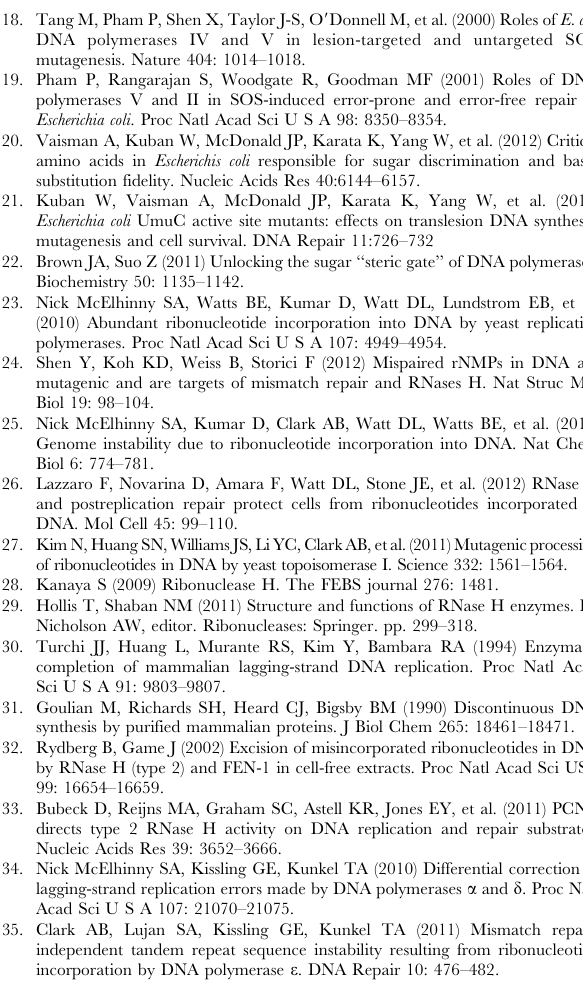
Figure S1 UV-survival of recA730 lexA (Def) D umuDC strains expressing pol V variants. Ten microliters of 10-fold serial dilutions of overnight cultures were spotted onto the surface of rectangular LB agar plates and exposed to 40 J/m 2 (panels A and C) and 10 J/m 2 (panel B) 254 nM UV-light. Both unirradiated ( 2 ) and UV-irradiated ( + ) plates were incubated overnight at 37 u C. In each panel, UV survival is shown for the recA730 lexA (Def) D umuDC strains either harboring pGB2 vector, or expressing pol V variants. Figure S2 UV-survival of recA730 lexA (Def) D umuDC polB + / D polB strains expressing pol V variants. Panel A and C, rnhB + ; Panel B and D, D rnhB . Ten microliters of 10-fold serial dilutions of overnight cultures were spotted onto the surface of rectangular LB agar plates and exposed to 40 J/m 2 254 nM UV-light. Both unirradiated ( 2 ) and UV-irradiated ( + ) plates were incubated overnight at 37 u C. In each panel, UV survival is shown for the